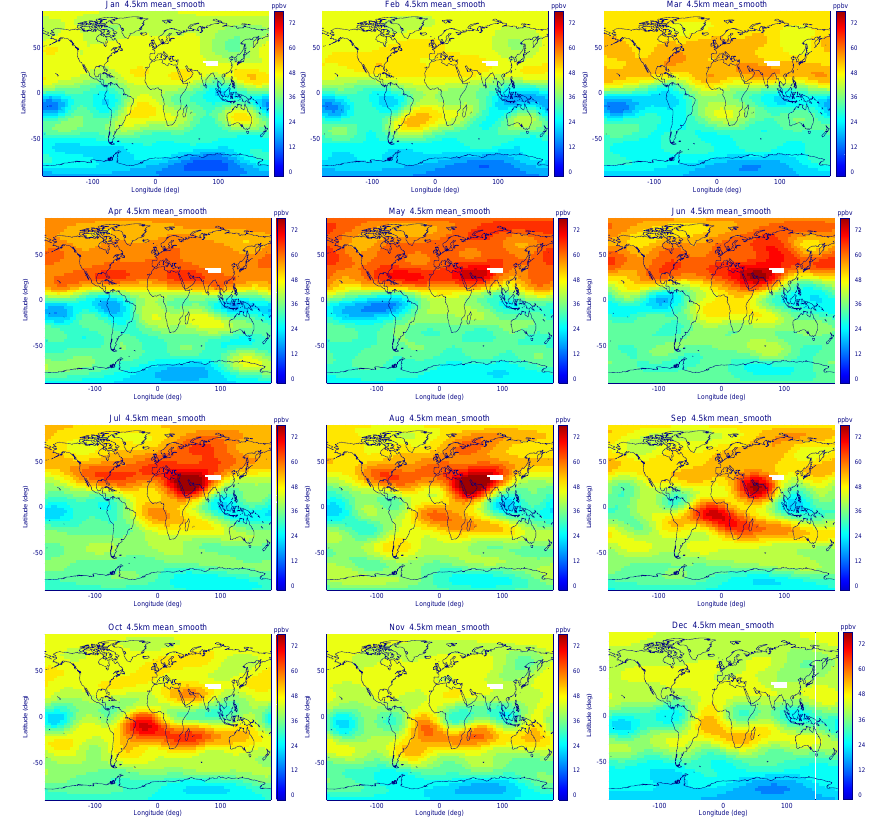
Fig. 7. As Fig. 6 but for 4.5km altitude above sea Figure 7: As Figure 6, but for 4.5 km altitude above sea level.